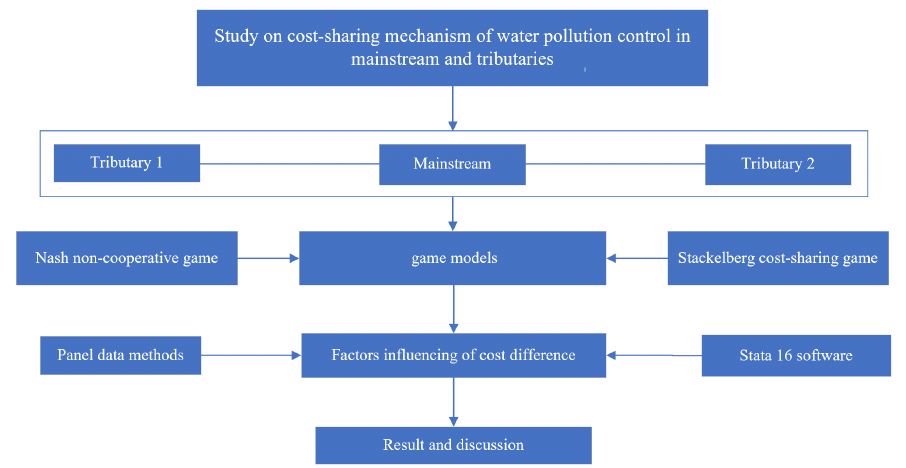
Figure 2. The flowchart of the study methodology.